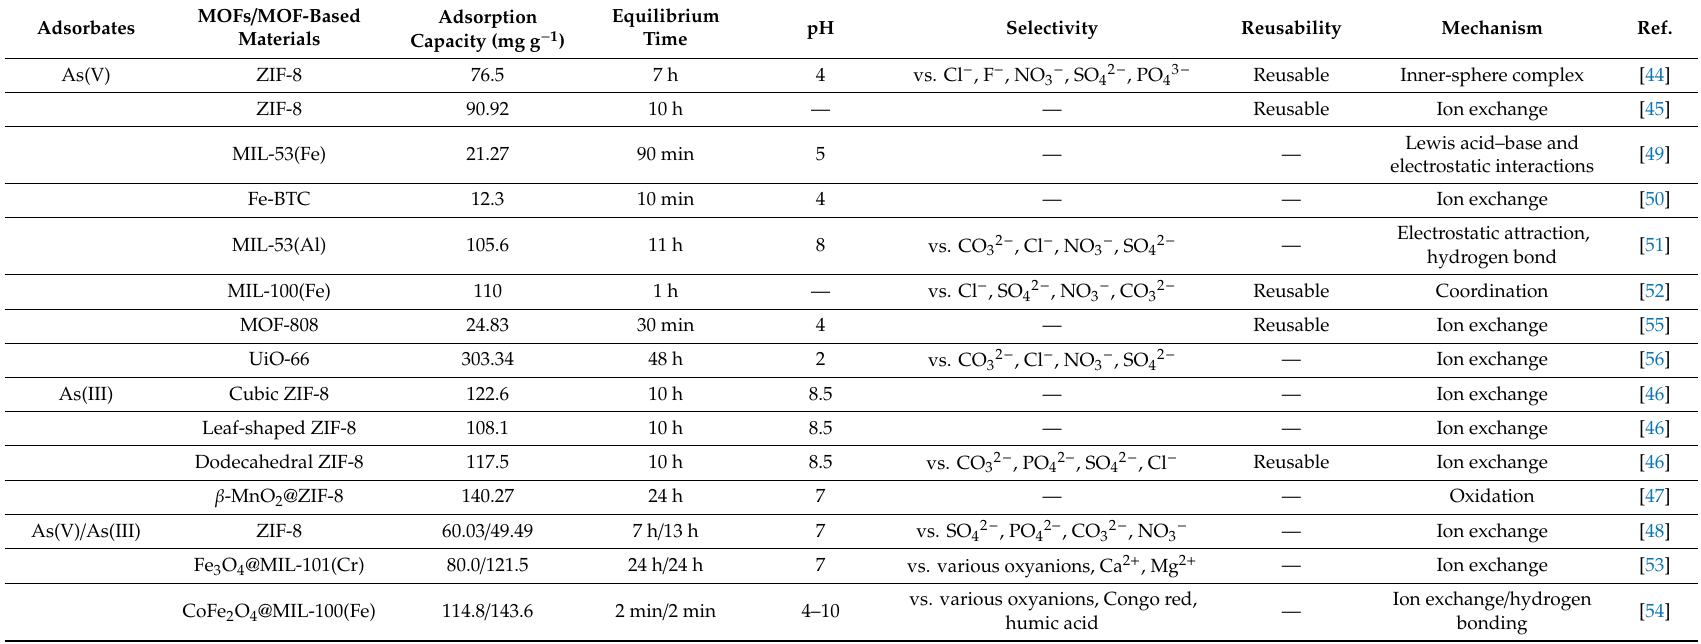
Table 1. Arsenic adsorption data for the reported Metal–organic frameworks (MOFs) and MOF-based